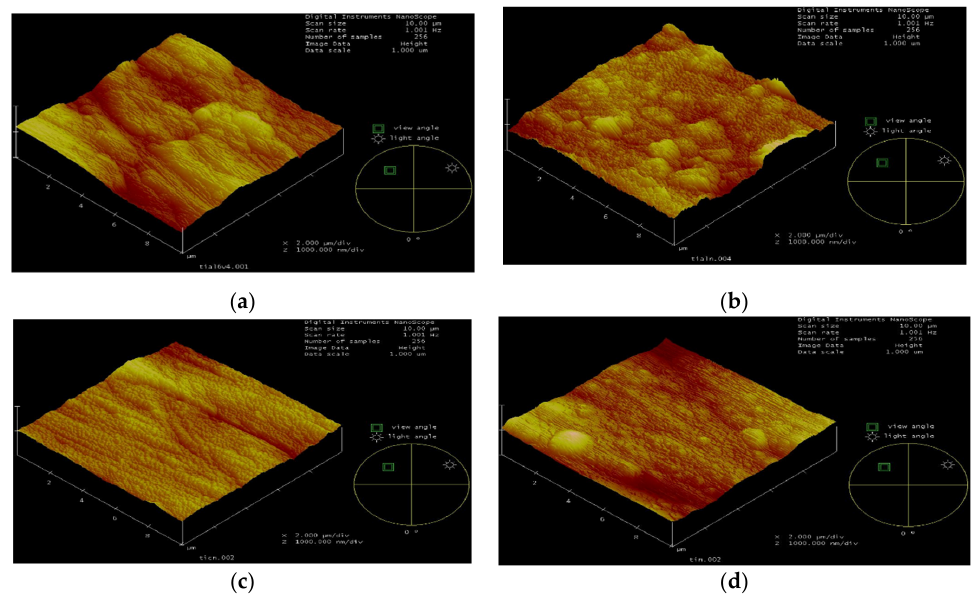
Figure 4. Atomic force microscope images; ( a ) Ti6Al4V, ( b ) TiAlN, ( c ) TiCN, ( d ) TiN. AFM images show that a dense and crack-free surface structure is obtained after the coating. The surface contains buds which might have formed due to formation of thinner and columnar structures. The cross-sectional scanning electron microscope image of the TiN coating is shown in Figure 5a, and the qualitative analysis of EDX obtained in the marked region is shown in Figure 5b. According to this analysis, 90.75% Ti and 9.25% N were determined. Similarly, EDX analysis of the Ti6Al4V alloy shows 89.46% Ti, 6.02% Al and 4.51% V. EDX analysis of the TiCN coated Ti alloy has values of 31.48% C, 61.06% Ti and 7.46% N. EDX analysis obtained for TiAlN coated samples show 39.87% Al, 33.86% Ti and 25.82% N.